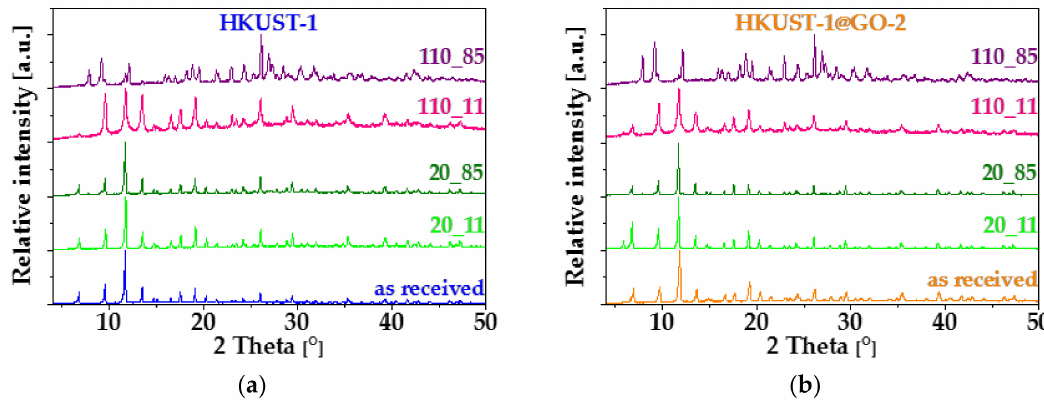
Figure 9. XRD profiles of ( a ) HKUST-1 and ( b ) HKUST-1@GO-2 before and after exposure to humid air. Blue and orange patterns belong to initial air-dried HKUST-1 and HKUST-1@GO-2, respectively. Initial air-dried (20 ◦ C) and activated (110 ◦ C, vacuum) materials were exposed to RH 11% and 85% at 25 ◦ C for 21 days and then measured without further treatment.